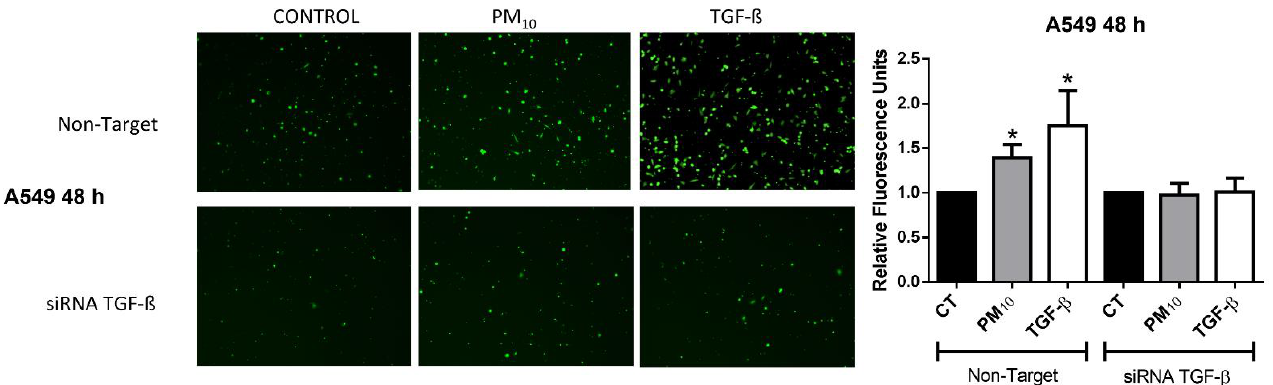
Figure 4. Particulate matter PM 10 activates the invasive phenotype in A549 cells. Particulate matter exposure increases the invasiveness of A549 cells exposed to PM 10 and transfected with non-targeting siRNA, with a similar effect in cells treated with TGF-β for 48 h. These effects are prevented in A549 cells transfected with TGFB1 siRNAs. Cells were exposed to PM 10 (10 µg/cm 2 ) and TGF-β (5 ng/mL) for 48 h. The quantitative results were expressed after obtaining the relative fluorescence units of each condition. Data are reported as the means ± SD of three independent experiments. The images are repre- sentative of data obtained. (*) indicates statistical differences between treatments p <